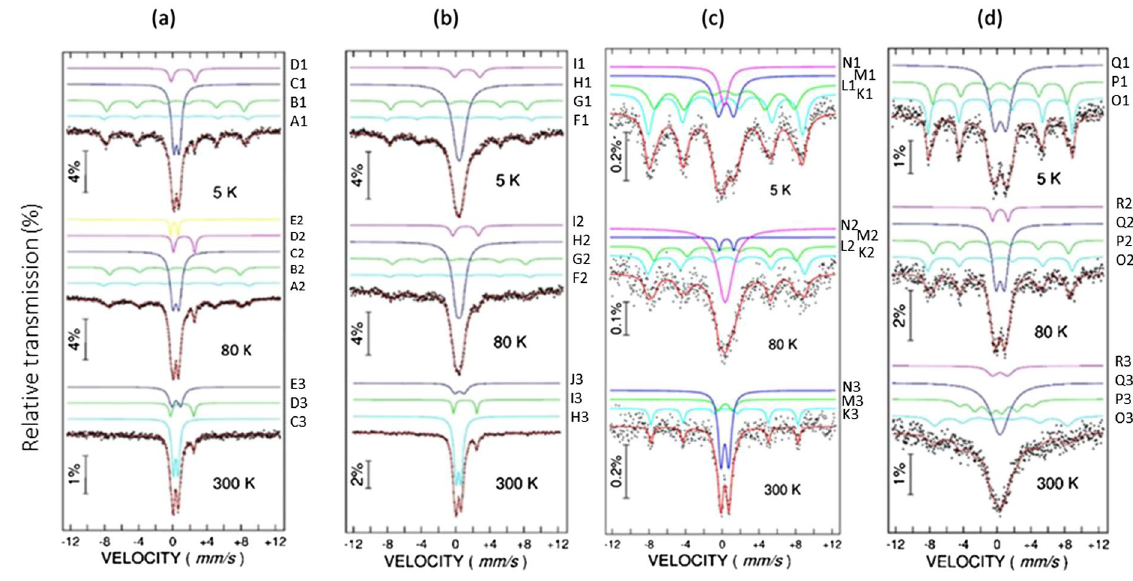
Figure 10. M ӧ ssbauer spectra at 5, 80 and 300 K measured on samples: ( a ) PCRT9R; ( b ) S1–2; ( c ) S1–2*; ( d ) B (for sample notation see Table 1). With points are experimental 5 K down to 48.52 T at 80 K in PCT9R and from 50.12 T at 5 K down to 49.05 T at 80 K in S1–2. It is worth not- ing that the isomer shift values assigned to both sextets in the two samples (0.40(5) mm/s and 0.40(5) mm/s in PCT9R and 0.50(5) mm/s and 0.40(5) mm/s in S1–2 at 5 K) are specific to Fe 3+ ion configurations. With a further